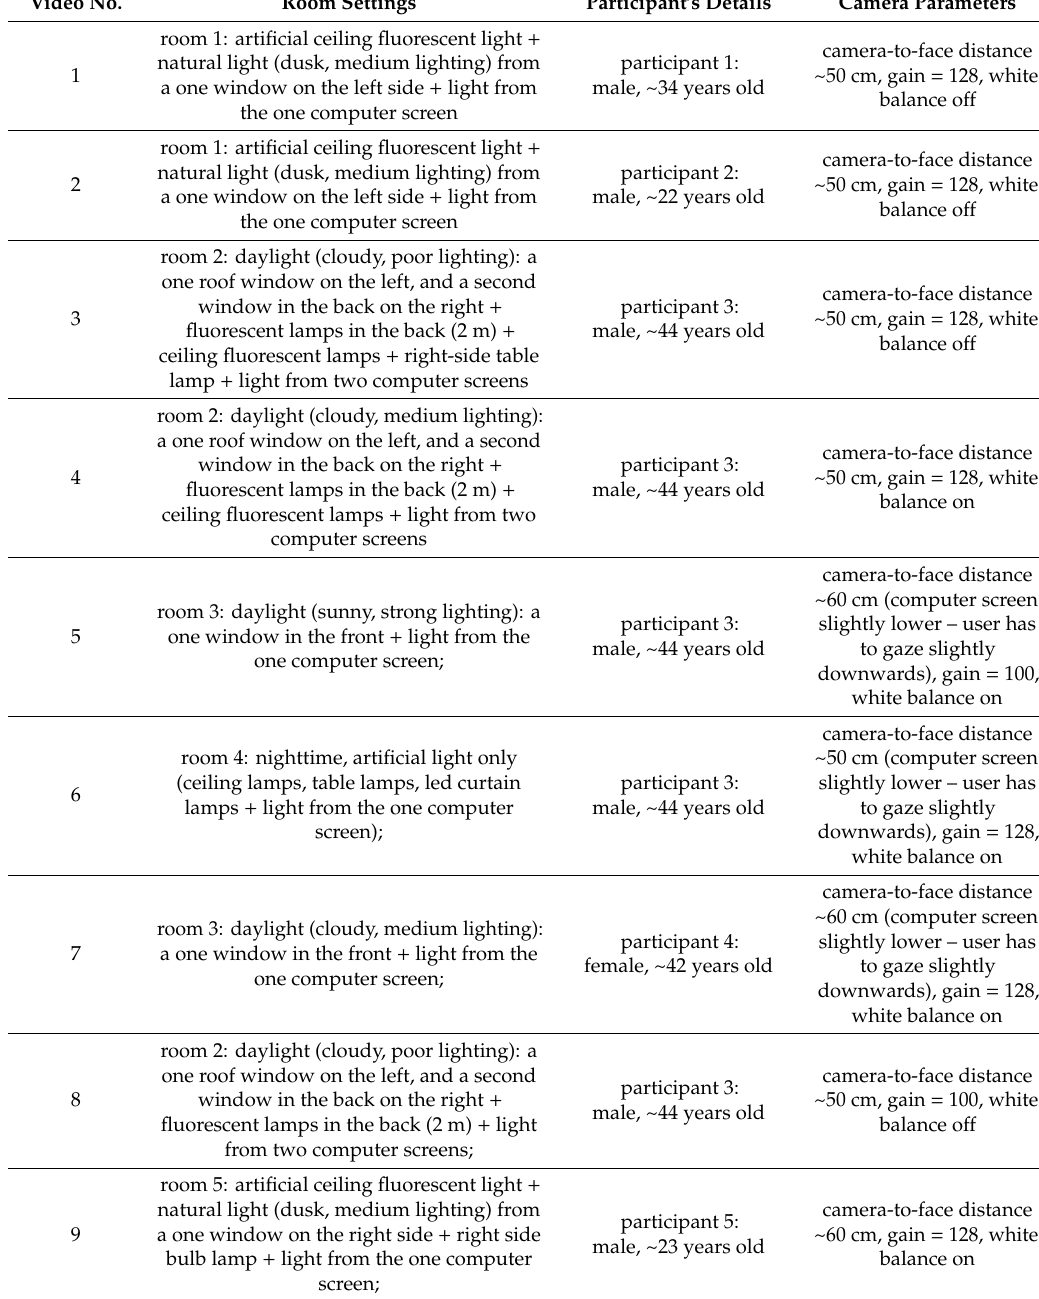
Table 2. Recorded video sequences covered by the